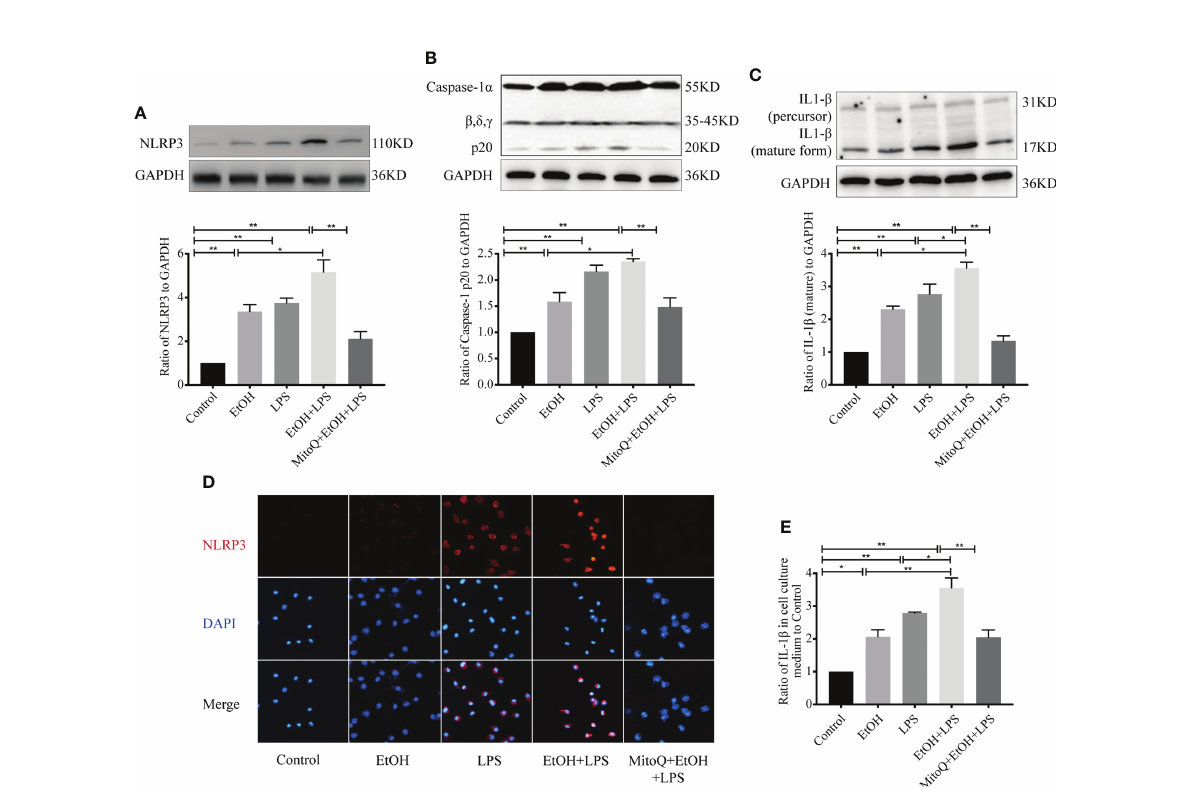
FIGURE 6 MitoQ decreased ethanol-LPS-induced injury in Raw264.7 cells by reducing NLRP3 in fl ammasome activation. Protein expression of NLRP3 (A) , Caspase-1 (B) , and IL-1 b (C) in the Raw264.7 cell was shown by western blotting. (D) Protein NLRP3 (red 400×) in fl ammasome activation was analyzed by immuno fl uorescence. (E) Protein IL-1 b in cell culture medium was detected by ELISA. All data were presented as mean ± SEM (n=5 in each group), *P < 0.05, **P <